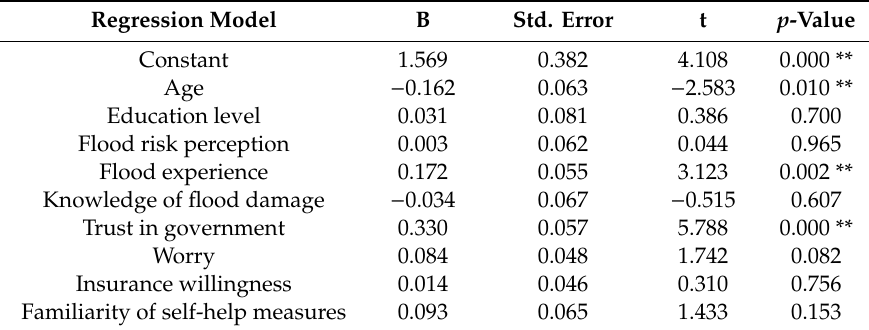
Table 5. Coe ffi cients of the linear regression